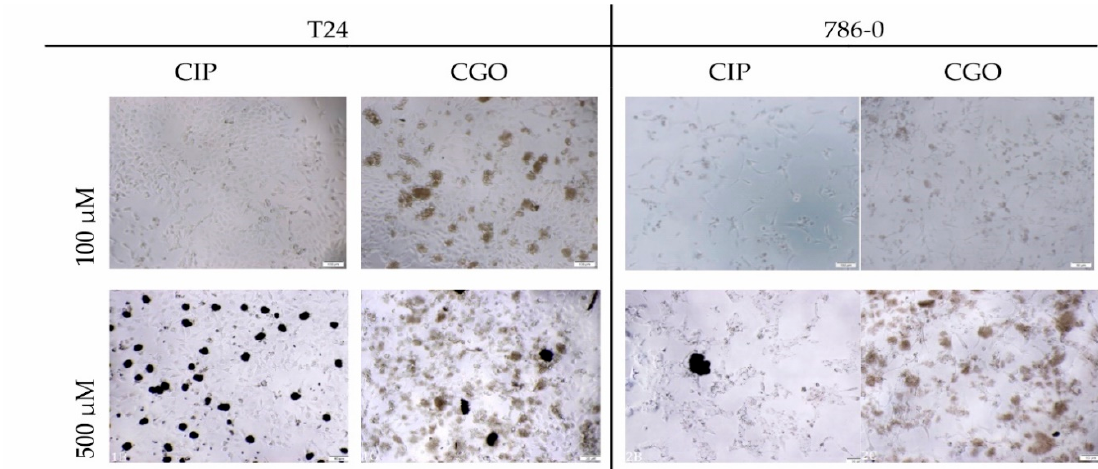
Figure 10. Morphology of T24 and 786-0 cells after 72 h incubation. Magnification ×50.